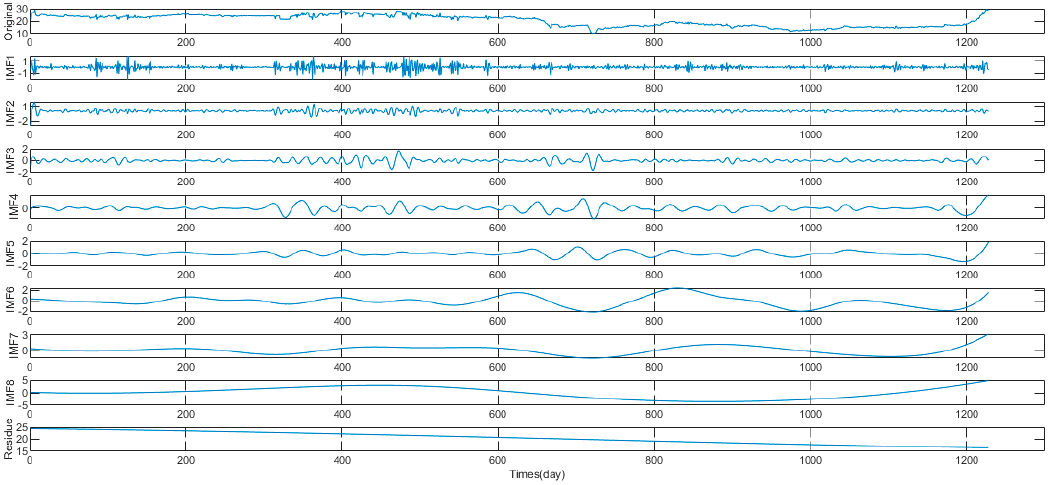
Figure 6. The results of the Hubei carbon price decomposed by EMD.